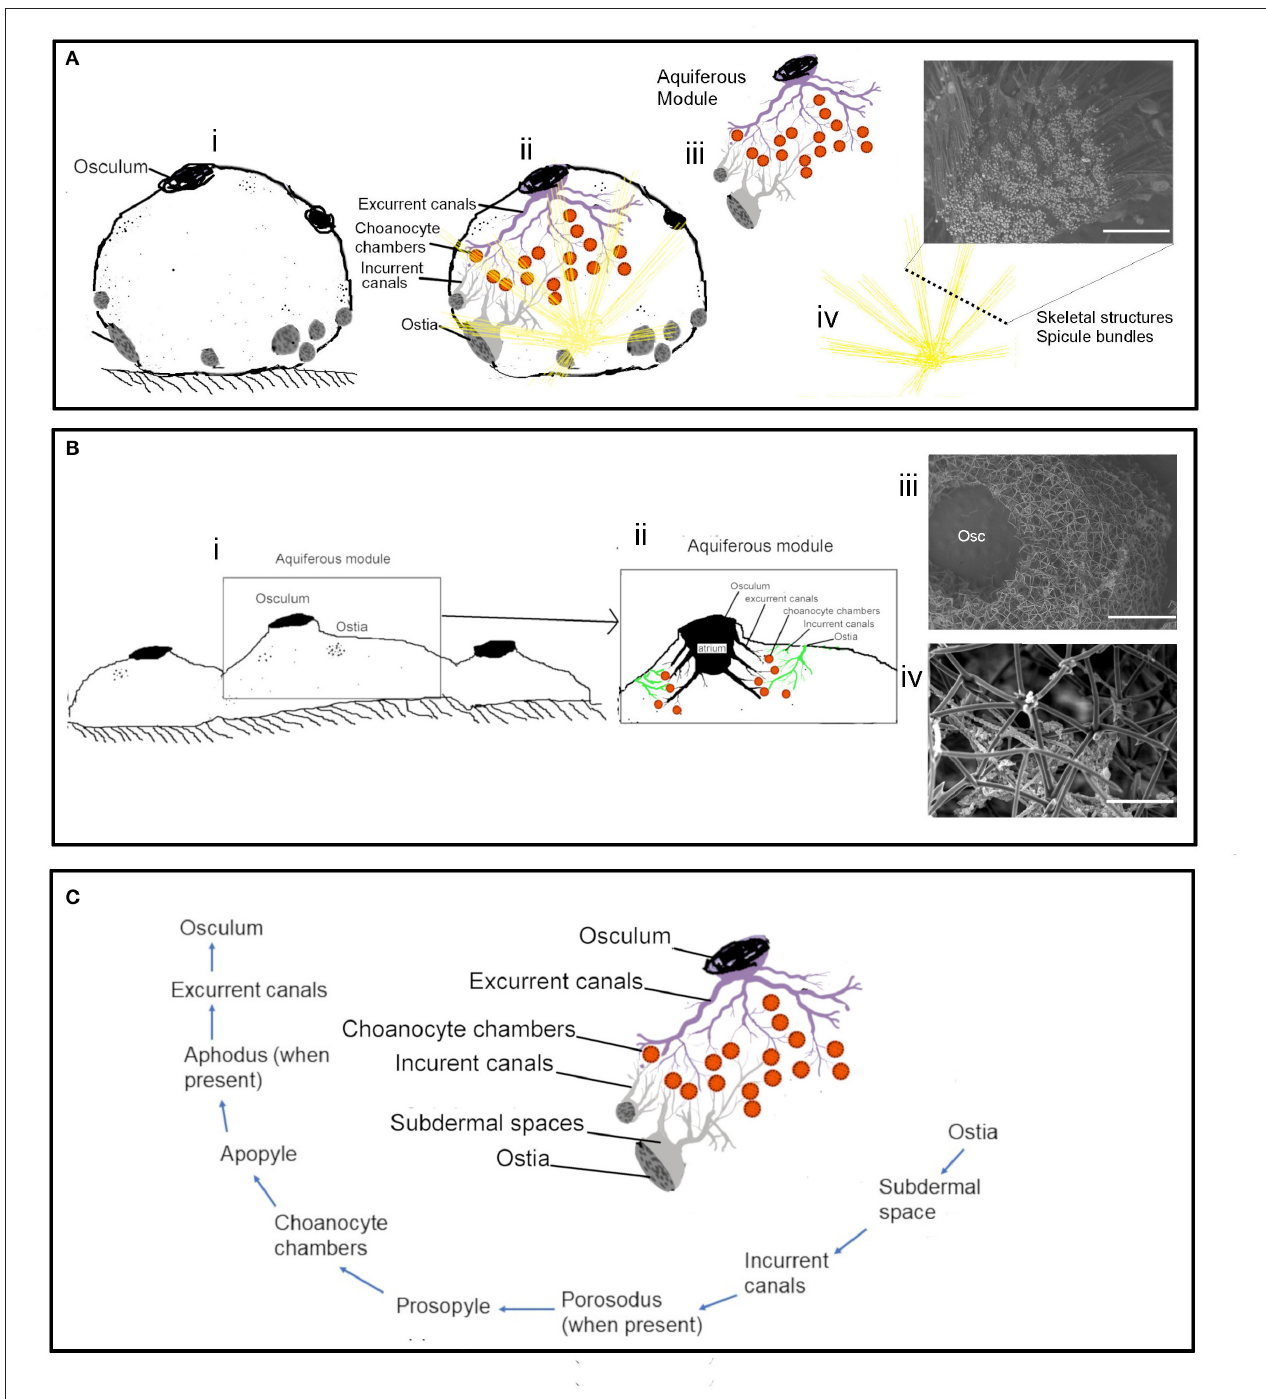
FIGURE 10 | The aquiferous system and the skeletal system in different morphologies: (A) Schematic representation of the spherical-shaped sponge Cinachyrella cf. cavernosa (i) the aquiferous system associated with a single osculum and the skeletal structures with the radiating spicule bundles (ii). the functional unit of the aquifeorus system-aquiferous module (iii). The skeleton of radiating spicule bundles, the dotted line represents a transverse section of the spicule bundles as seen in an SEM (iv). (B) Encrusting morphology of sponge (i). Aquiferous module (ii) with the SEM of the skeleton structure of Calyspongia sp. (iii) and Haliclona sp. (C) The components of an aquiferous module and the path of the water through the aquiferous system of sponge.